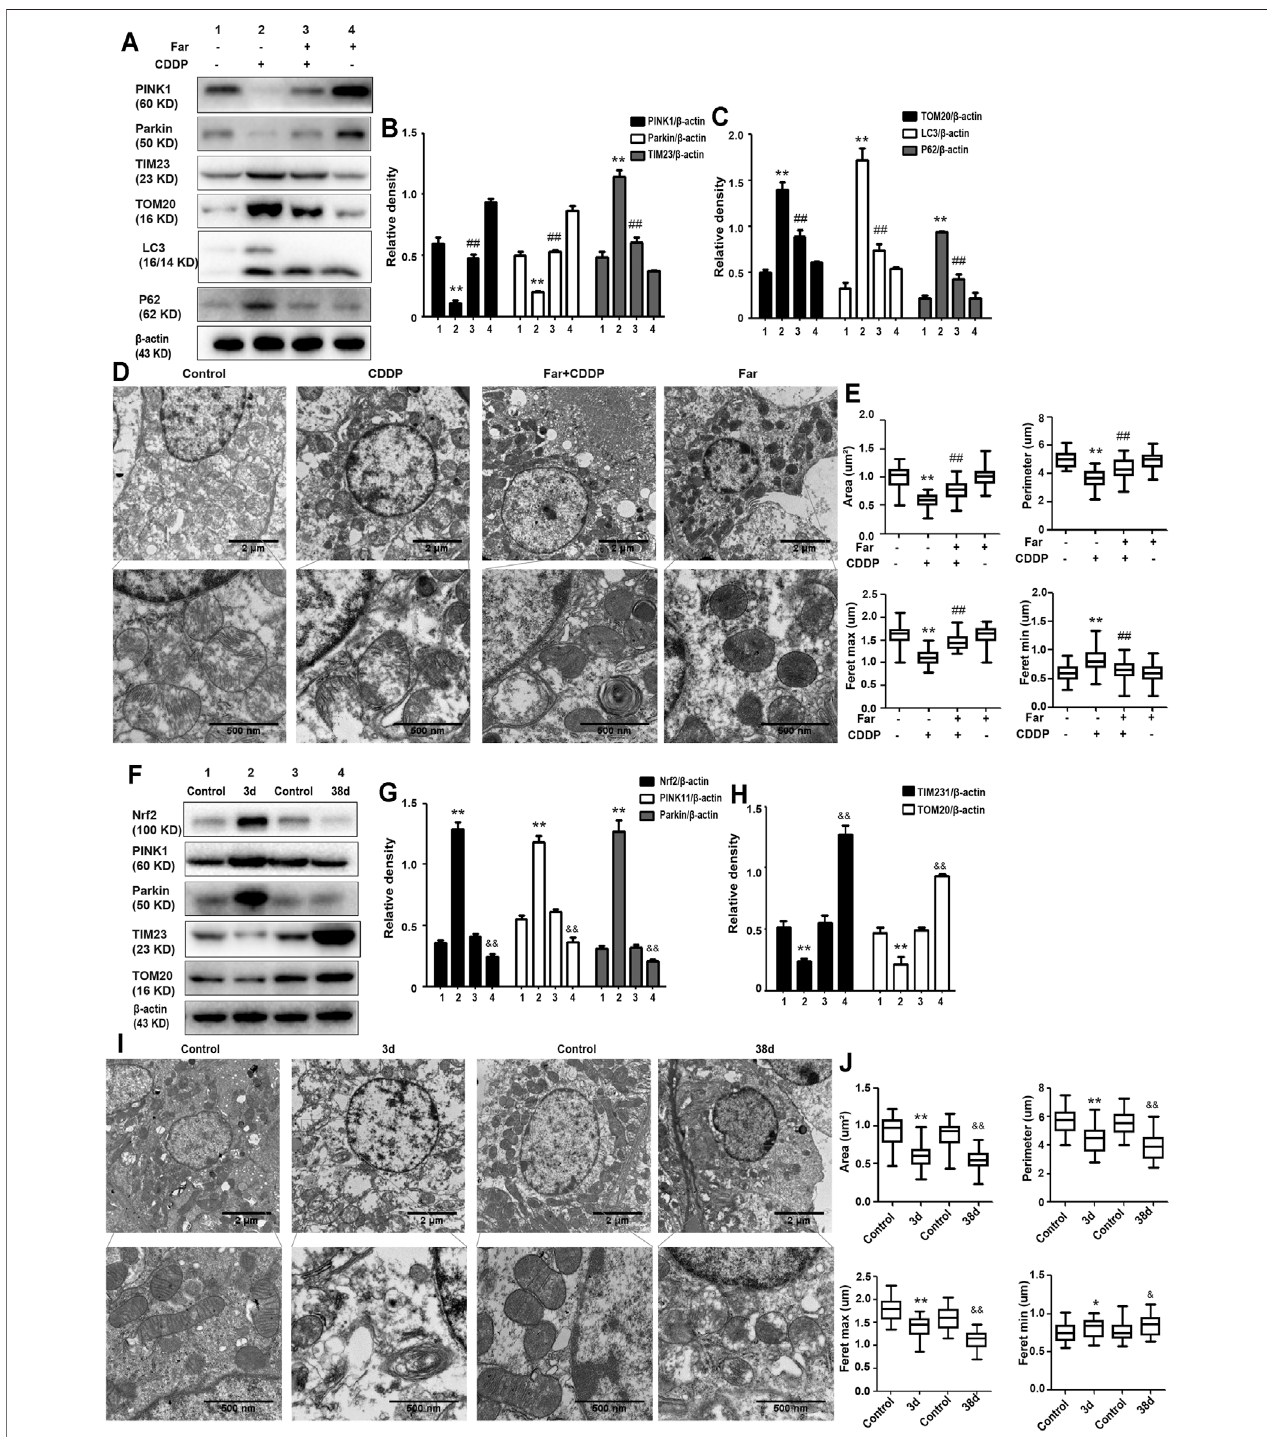
FIGURE4| Theeffect ofCDDPon theNrf2-and PINK1/Parkin-related mitophagy pathwaysin AKIand CKD. (A – C) ImmunoblotanalysisofPINK1, Parkin,TIM23, TOM20, LC3, and P62. (D,E) Representative TEM images of mitochondrial morphology in renal tubular epithelial cells. Data were shown as quanti fi cation of mitochondrial contour measurements from n (cid:1) 6 mice per group. (F – H) Western blotting and densitometry analysis of Nrf2, PINK1, Parkin, TIM23, and TOM20. (I,J) Representative TEM images of autophagosomes/mitochondria in kidney tubular epithelial cells on day 3 and day 38 after the fi rst injection of cisplatin. All experiments were performed three times.Datawereshown as quanti fi cation ofmitochondrialcontourmeasurementsfrom n (cid:1) 6 mice per group. Dataare expressed as the mean ± SEM. & p < 0.05 and && p < 0.01 * p < 0.05 and ** p < 0.01 vs. the control group (CDDP-AKI mice); * p < 0.05 and ** p < 0.01 vs. the control group (CDDP-CKD mice); # p < 0.05 and ## p < 0.01 vs. the CDDP group.